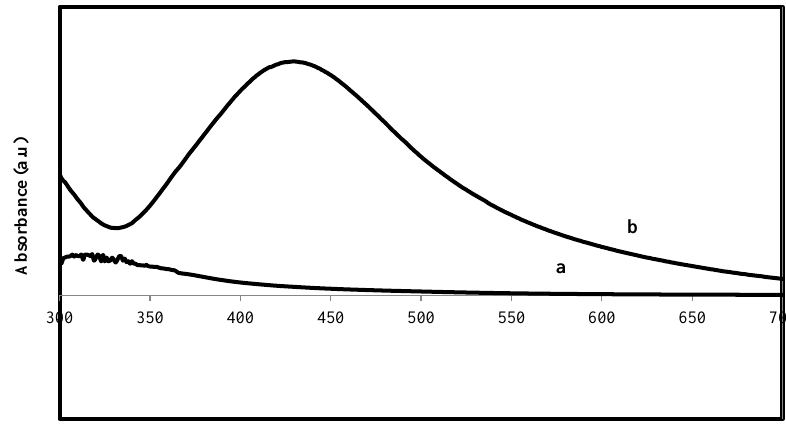
Figure 2. UV–Visible spectrum of ( a ) S. muticum aqueous extract; and ( b ) S. muticum formed